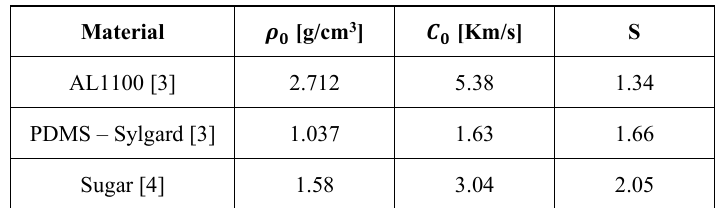
Table 1. EOS paramètres for different materials